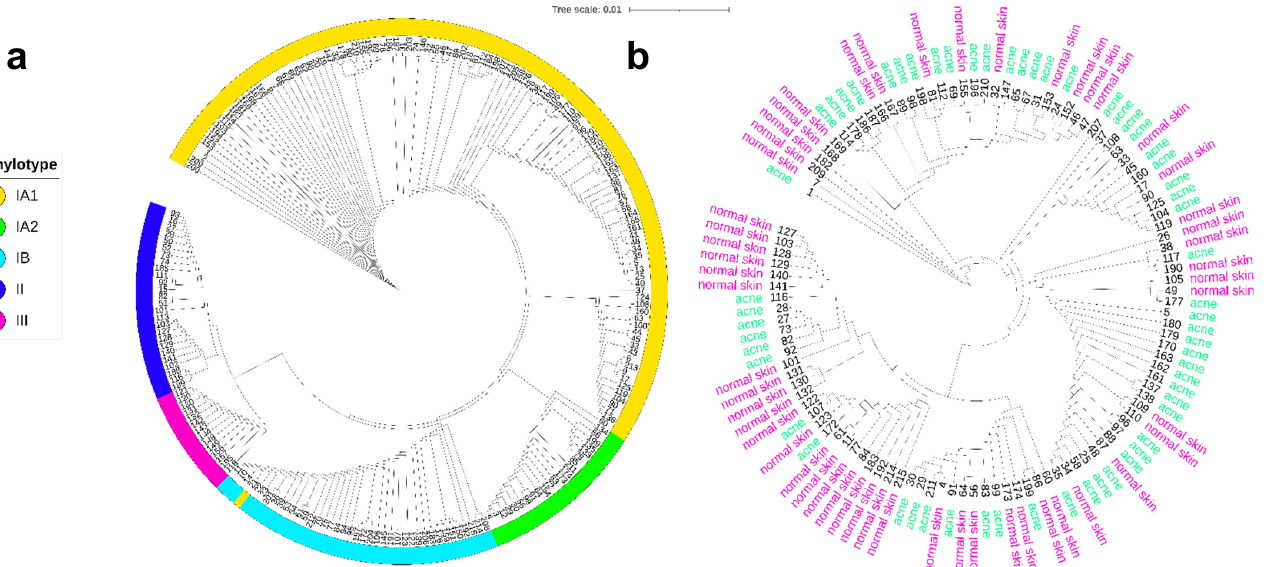
Figure 2. Cutibacterium acnes clonal population structure and distribution on normal and acne skin. ( a ) Neighbor-joining tree created using iTOL tool [66] from concatenated nucleotide sequences of MLST schemes [67] from all the current strains in the database published by Jolley et al., 2018 [68]. Over the 215 different isolates, 114 (53%) are classified in the subtype IA 1 , 22 (10%) in the subtype IA 2 , and 39 (18%) in the subtype IB of the major phylogenetic group type I. The rest are classified in the phylogenetic groups II (26 isolates, 12%) and III (14 isolates, 6%). Considering the sources of all the strains in the database, the majority, 112 (52%), have been isolated from skin samples. The rest of the strains have been isolated from samples categorized as eye, prostate, other, blood, soft tissue, medical device, spinal disc, dental, and bone (19, 18, 14, 13, 12, 10, 10, 6, and 1%, respectively). ( b ) Neighbor-joining tree from concatenated nucleotide sequences of MLST schemes from all the isolates sourced as skin samples (acne and normal skin). From the total of 112 strains, 59 have been isolated from acne skin and 53 from normal skin. For acne skin, 44 (74%) are classified in the subtype IA 1 , 7 (11%) in the subtype IA 2 , 2 (3%) in the subtype IB, 6 (10%) in the phylogenetic group II, and 0 in the phylogenetic group III. For normal skin, 27 (50%) are classified in the subtype IA 1 , 6 (11%) in the subtype IA 2 , 10 (18%) in the subtype IB, 7 (13%) in the phylogenetic group II, and 3 (6%) in the phylogenetic group III.